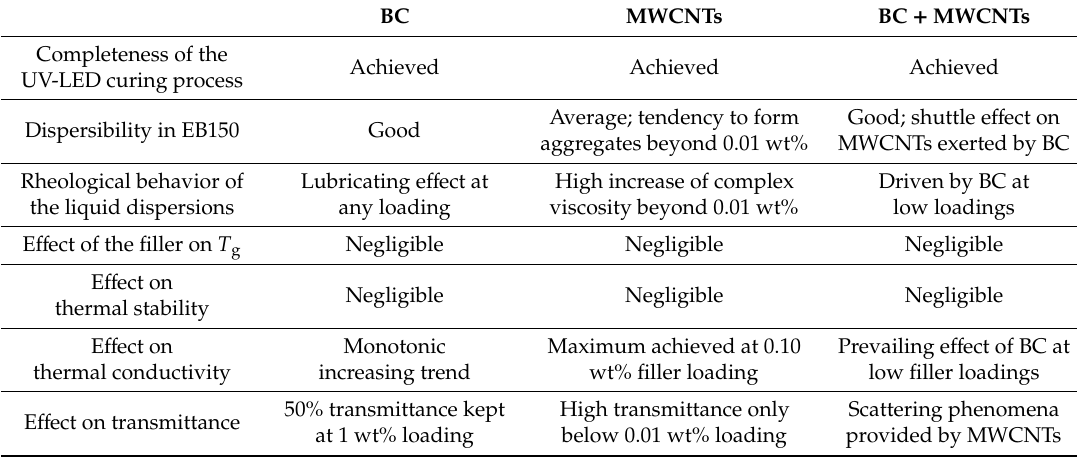
Table 2. Main outcomes from the investigated